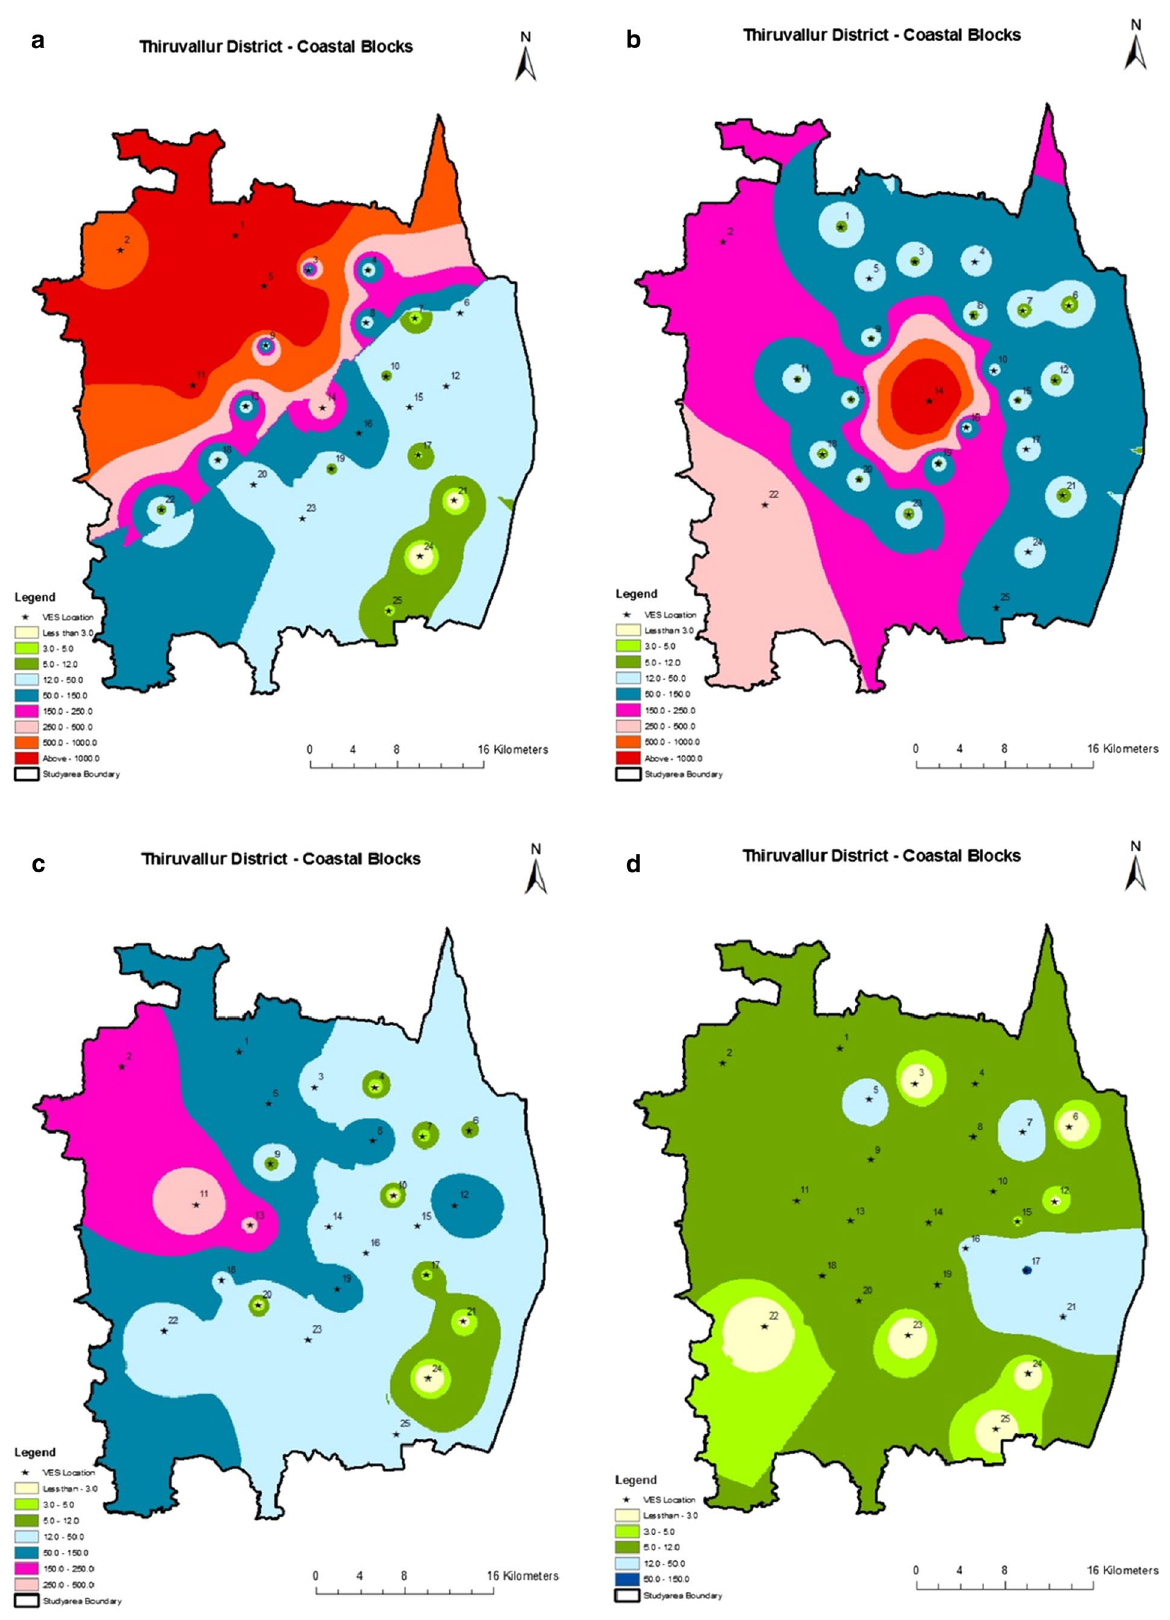
Fig. 10 a First-layer resistivity. b Second-layer resistivity. c Third-layer resistivity. d Fifth-layer